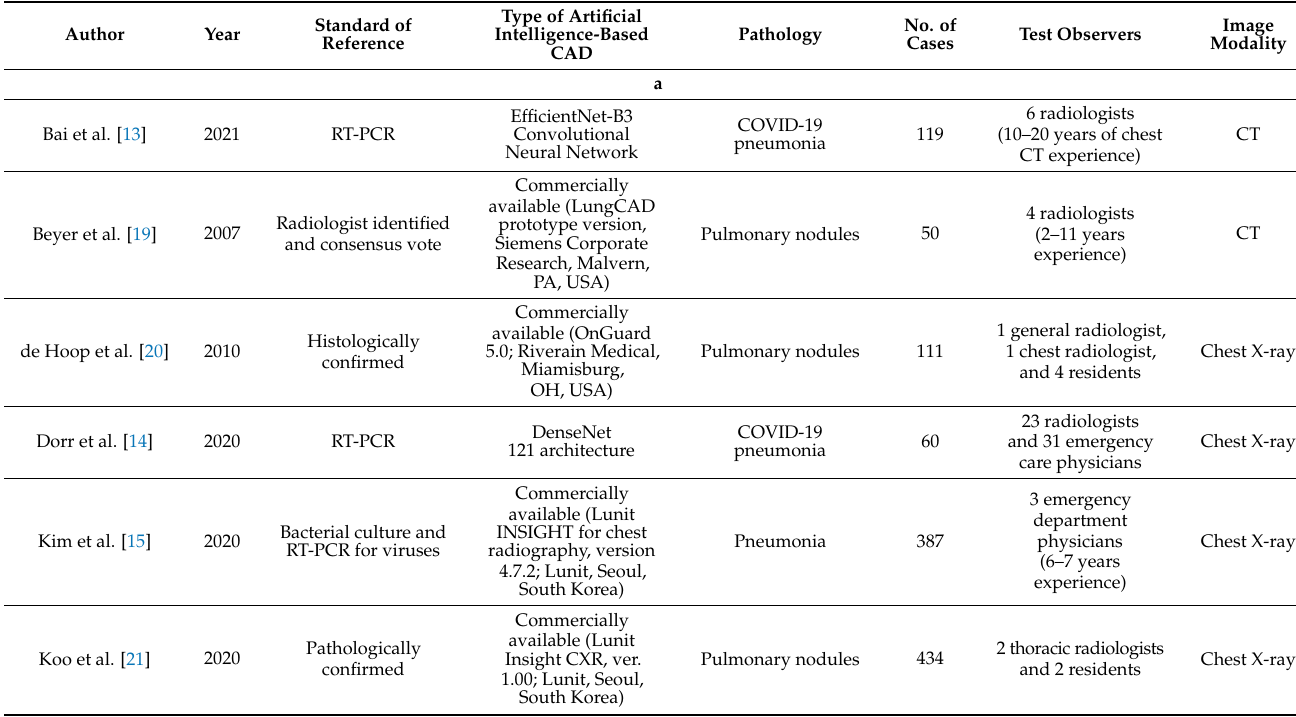
Figure 2. Preferred reporting items for systematic reviews and meta-analyses (PRISMA) flowchart of the literature search and study selection. Table 1. ( a ) Included studies with artificial intelligence-based devices as concurrent readers in the observer test. ( b ) Included studies with artificial intelligence-based devices in an observer test with a sequential test